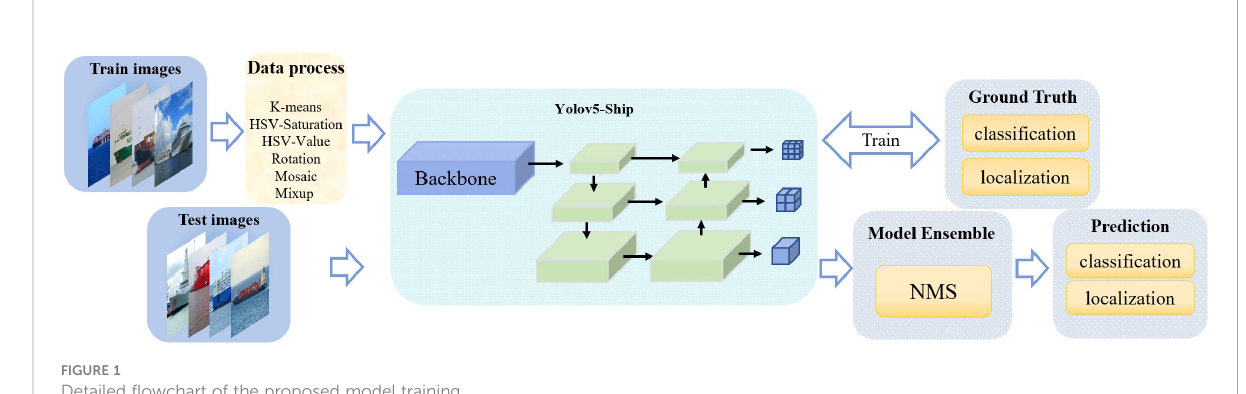
FIGURE 1 Detailed fl owchart of the proposed model